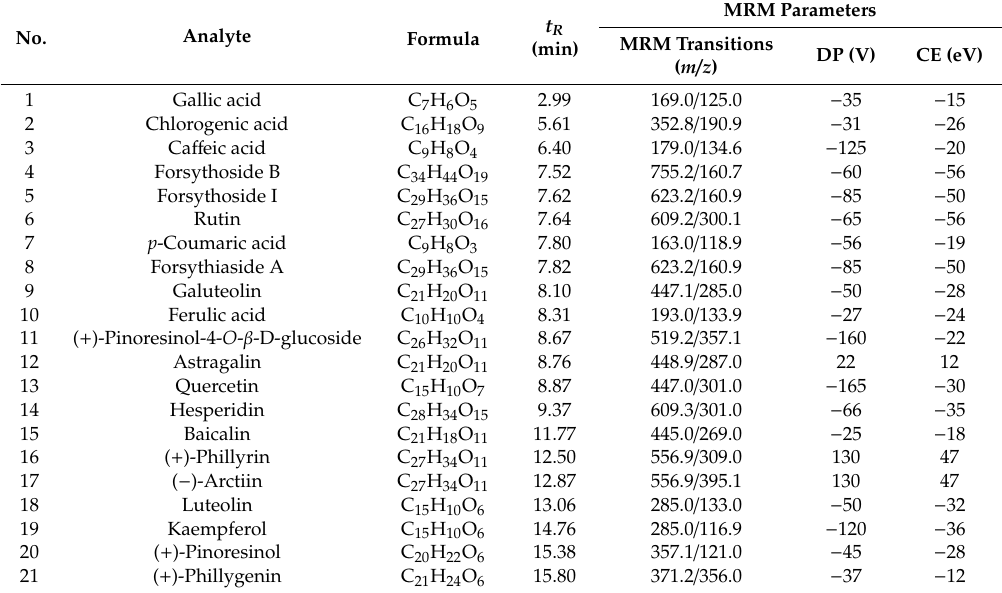
Table 1. Optimized mass spectrometric parameters for MRM of twenty-one